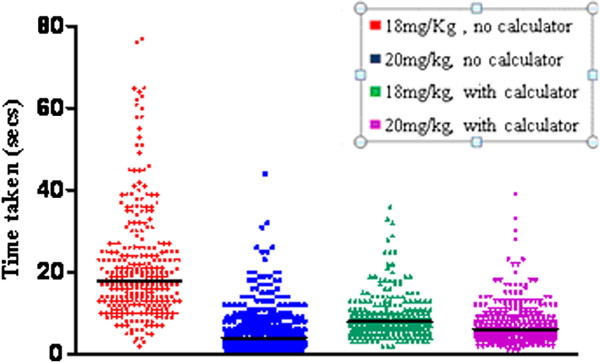
Scatter plot of time taken with and without a calculator to calculate 18 mg/kg and 20 mg/kg.